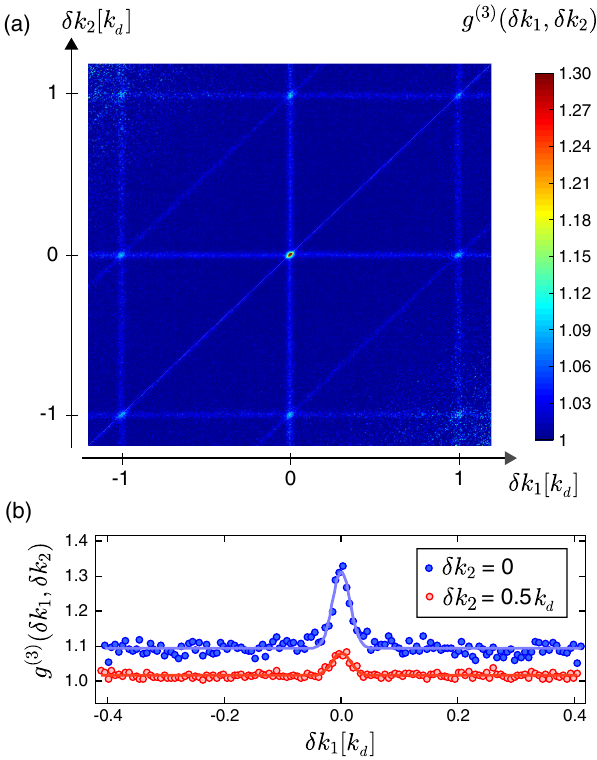
FIG. 4. Three-body momentum correlations in bosonic Mott insulators. (a) Plot of g ð 3 Þ ð δ k 1 ; δ k 2 Þ as a function of the algebraic distances δ k 1 and δ k 2 between atoms along the lattice axis (see the text). The background amplitude associated to uncorrelated atoms has an amplitude of approximately 1. The correlations along the lines defined by δ k 1 ¼ 0 , δ k 2 ¼ 0 , and δ k 1 ¼ δ k 2 correspond to the two-body bunching g ð 2 Þ ð 0 Þ associated with finding two atoms close by. The intrinsic three-body correlations ; δ k 2 ¼ 0 ½ k (located at δ k 1 ¼ 0 ½ k ) have an even higher ampli- d (cid:2) d (cid:2) tude. Here, we use Δ k ¼ 0 . 008 k d and Δ k ⊥ ¼ 0 . 1 k d . (b) Profiles jj of g ð 3 Þ ð δ k 1 ; δ k 2 Þ at δ k 2 ¼ 0 and δ k 2 ¼ 0 . 5 k . We find g ð 3 Þ ð 0 ; 0 Þ − d 0 . 065 ð 10 Þ , i.e., that the ratio 1 ¼ 0 . 32 ð 2 Þ and g ð 3 Þ ð 0 ; 0 . 5 k d Þ ¼ between the amplitudes of three-body and two-body correlations is compatible with the expected value for Gaussian